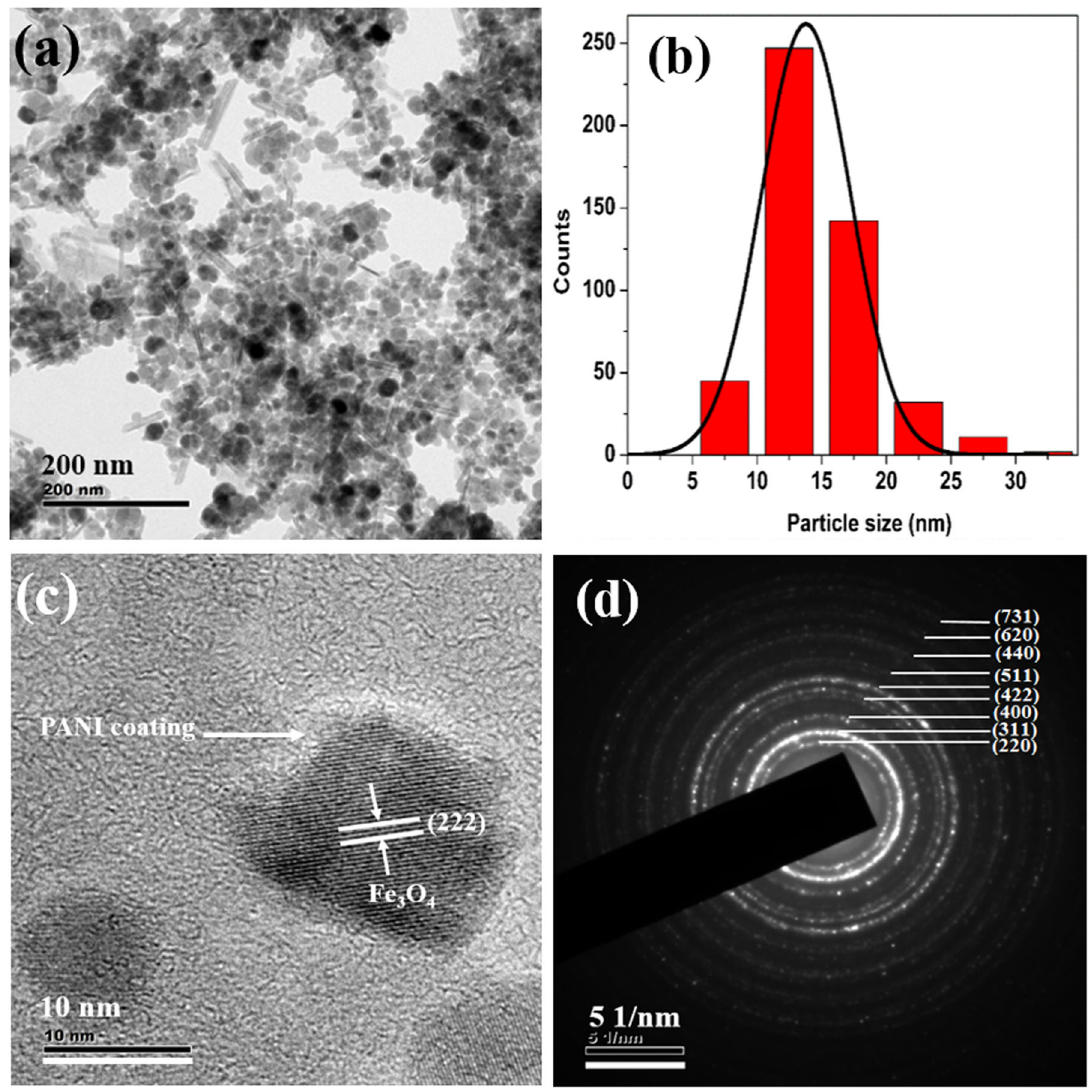
Fig. 4 a TEM image of PANI-coated Fe 3 O 4 , b histogram of particle sizes obtained from TEM, c HRTEM image and d SAED pattern of PANI- coated Fe 3 O